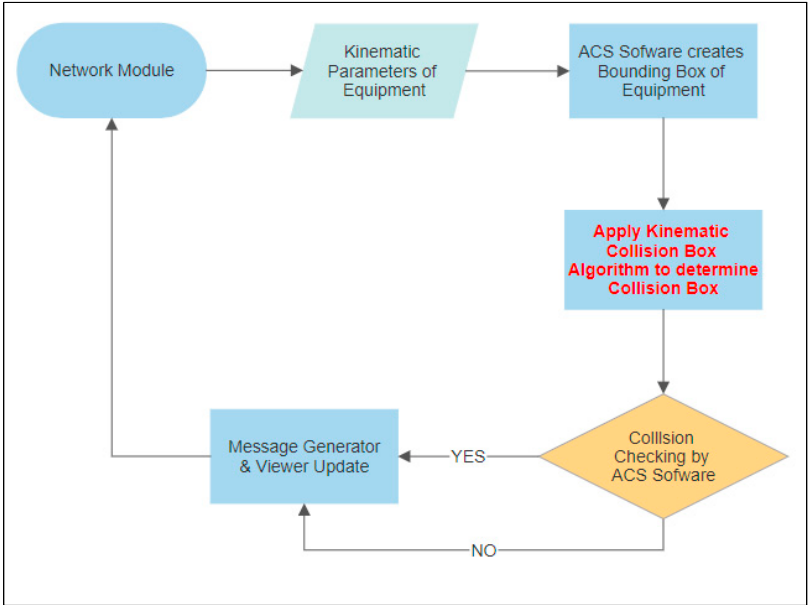
Figure 6. Kinematic Collision Box Algorithm in Data Processing Sequence.